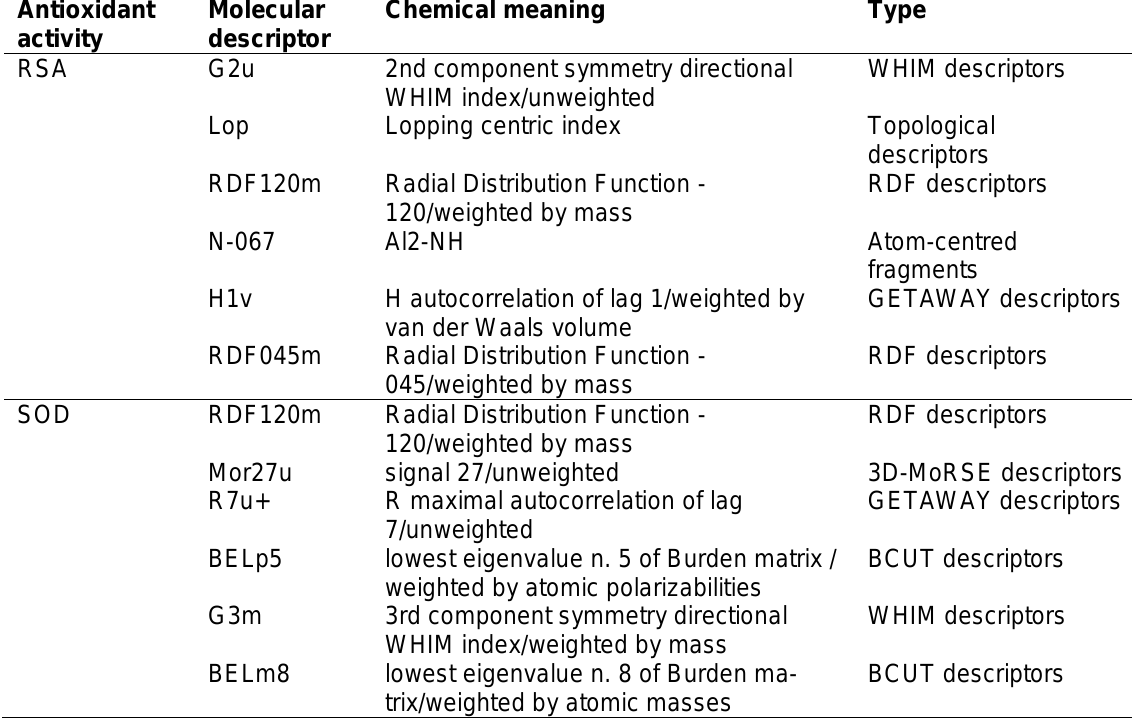
Table 2: Definition and types of significant molecular descriptors for QSAR construction